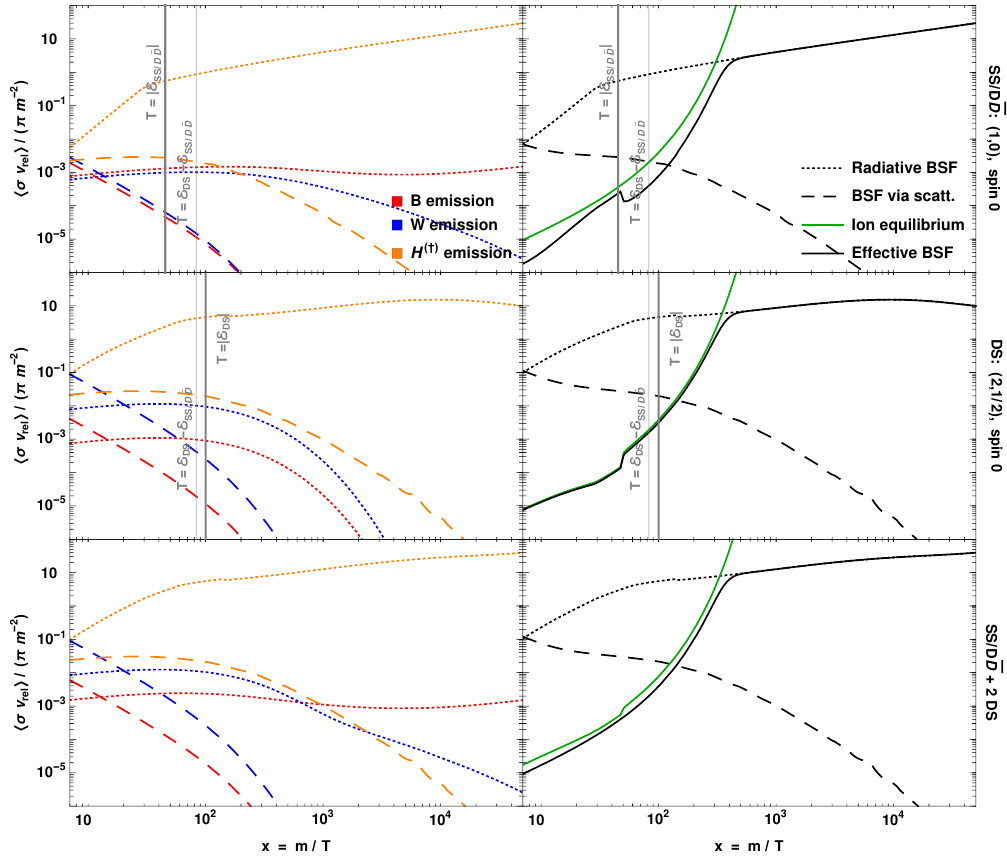
¯ Figure 2 . As in figure 1, but for the SS/D D and DS states that transition into each other via Higgs emission or absorption. The DS panels include the capture into its conjugate. In the bottom row, we show the sum of the SS/D ¯ D , DS and ¯ DS contributions. The vertical lines mark the temperatures equal to the binding energies and the energy splitting between SS/D ¯ D and DS . The feature around x ’ 50 occurs when the Higgs doublet mass becomes lower than the energy splitting between the two bound states; this opens up the bound-to-bound transitions via on-shell Higgs emission (at higher T they occur only via off-shell Higgs exchange with the thermal bath), and drives the SS/D ¯ D bound states somewhat away from ionisation